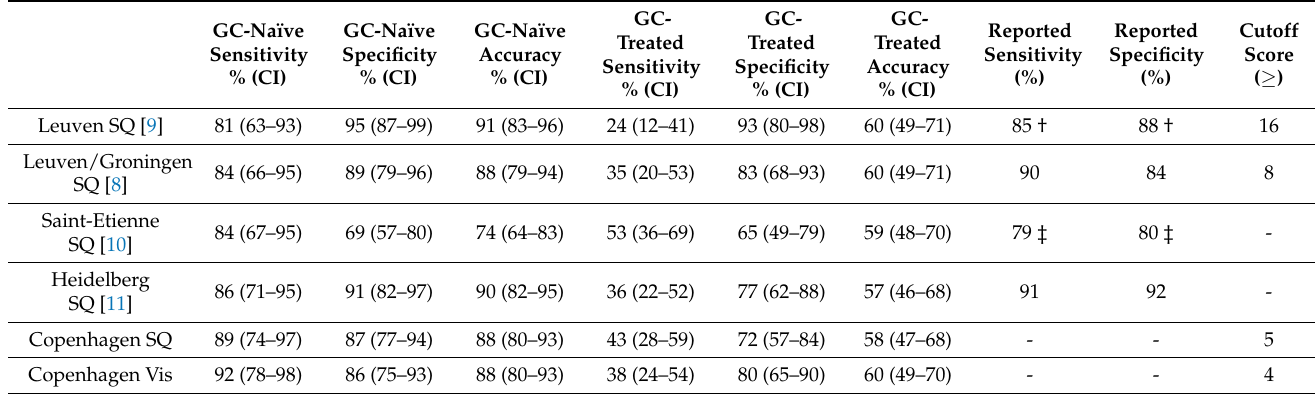
Table 3. Diagnostic performance (PMR or PMR + GCA versus other diagnoses) of different scoring systems in glucocorticoid-naïve patients versus patients treated with glucocorticoids. The originally reported data are stated in the last three columns.